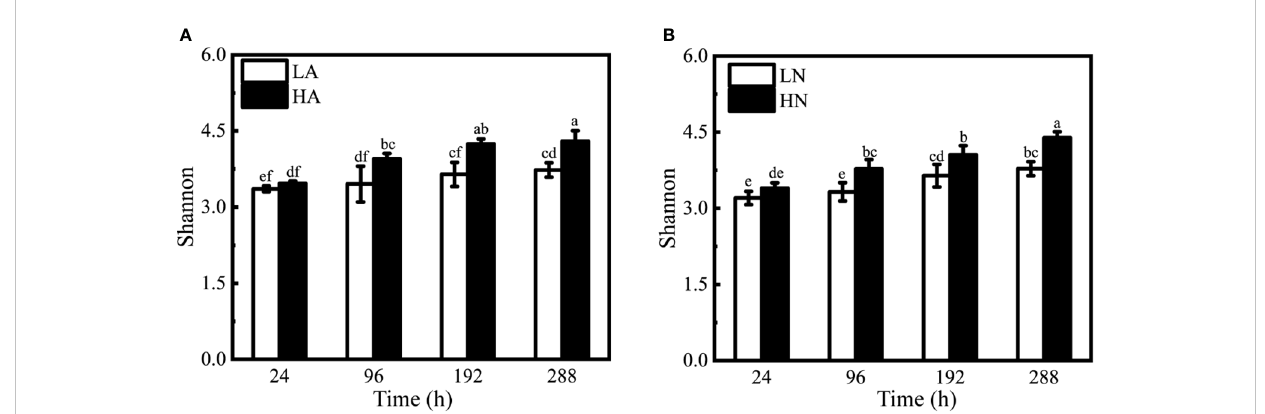
FIGURE 4 Shannon-Weaver indices of different treatment groups under the algal-bacteria co-culture system. (A) The comparison between the low concentration (LA) and the high concentration (HA) groups with ammonium. (B) The comparison between the low concentration (LN) and the high concentration (HN) groups with nitrate. Different lowercase letters indicate statistically signi fi cant